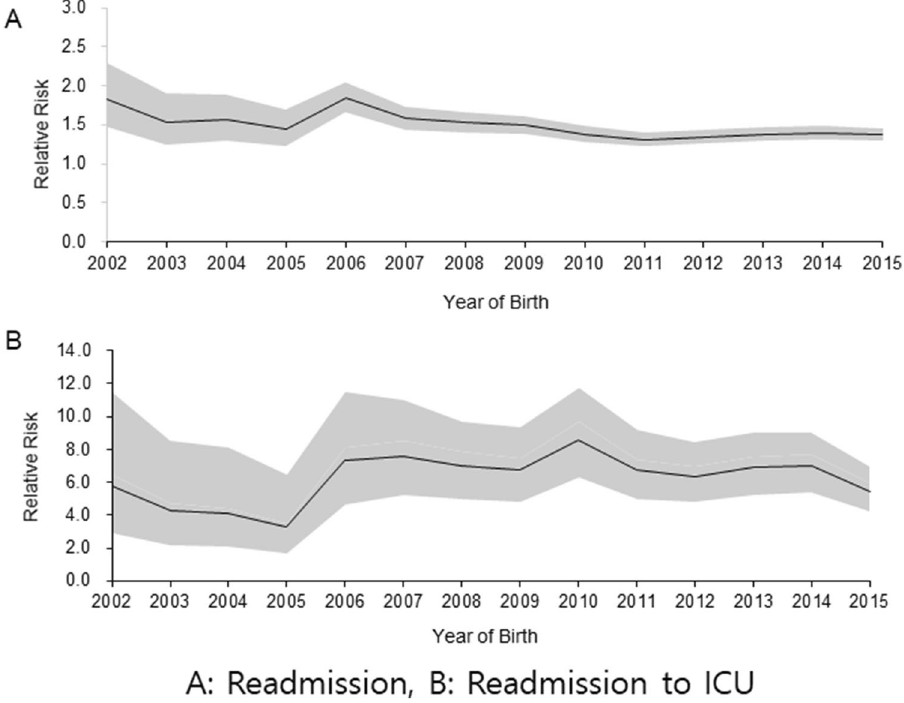
Figure 1. Trend in the relative risk of bronchopulmonary dysplasia on total readmission ( A ) and ICU admission ( B ) because of respiratory diseases. ICU intensive care unit.